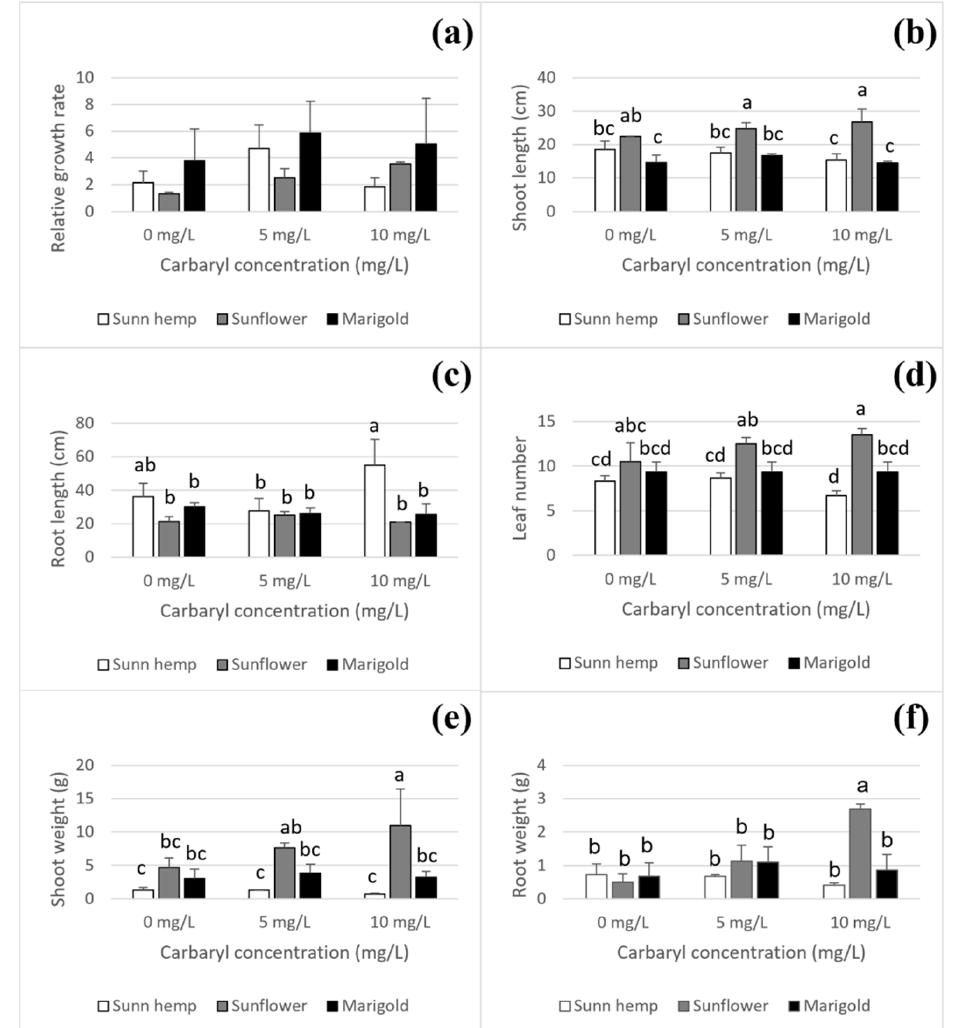
Figure 5. Effect of carbaryl on plant physiology after 4 days of cultivation for carbaryl treatments at 0, 5 and 10 mg L −1 ; relative growth rate ( a ), shoot length ( b ), root length ( c ), leaf number ( d ), shoot weight ( e ), and root weight ( f ). Note: a, b, c, and d indicate significant differences based on ANOVA and Tukey's HSD test. The data shown are mean and SD.